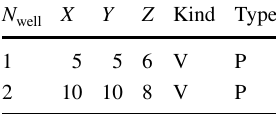
Table 6 Well input data of